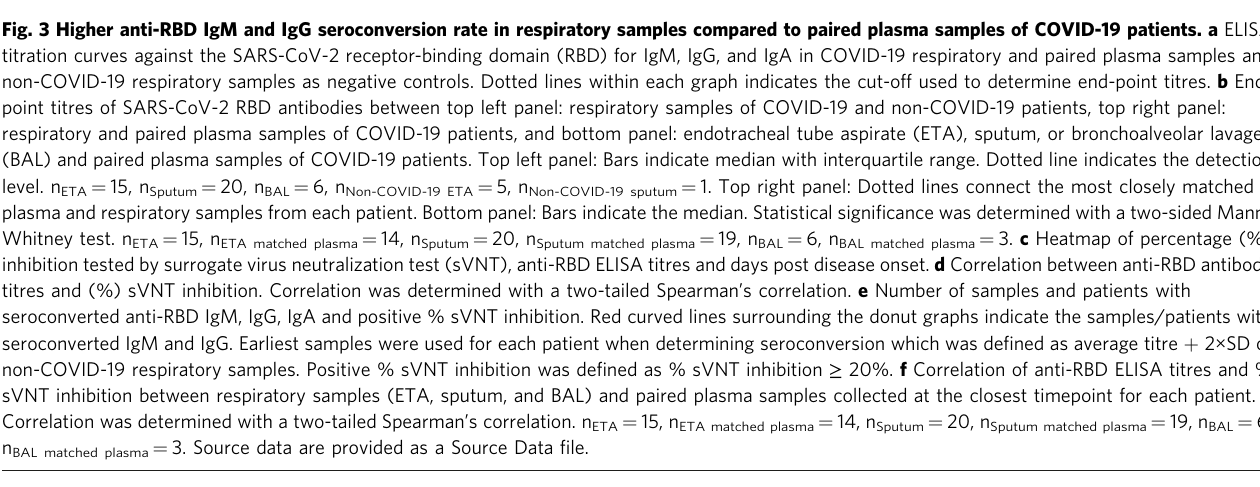
n BAL matched plasma = 3. Source data are provided as a Source Data